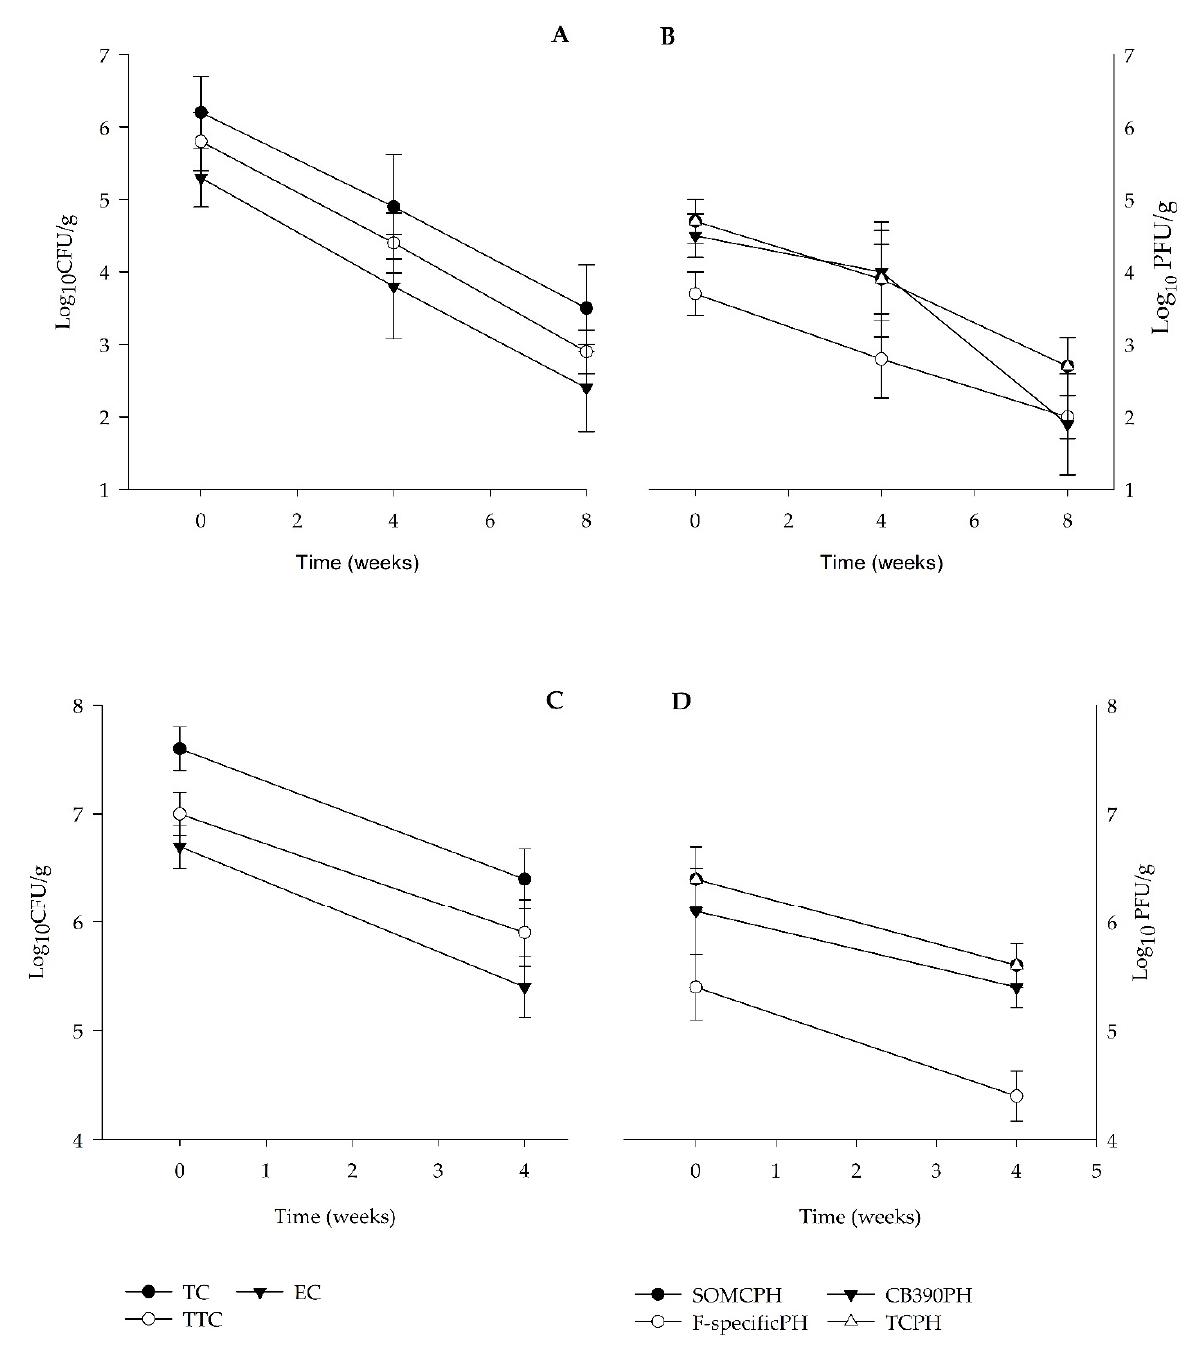
Figure 3. La Calera ( A , B ) and Chiquinquirá ( C , D ) WWTPs microbiological indicators in untreated and treated sludge as a function of time (weeks). TC: Total Coliforms, TTC: Thermotolerant Coliforms, EC: E. coli , SOMCPH: Somatic Coliphages, F-specificPH: F-specific Coliphages, PHCB390: CB390 phages, TCPH: Total Coliphages.